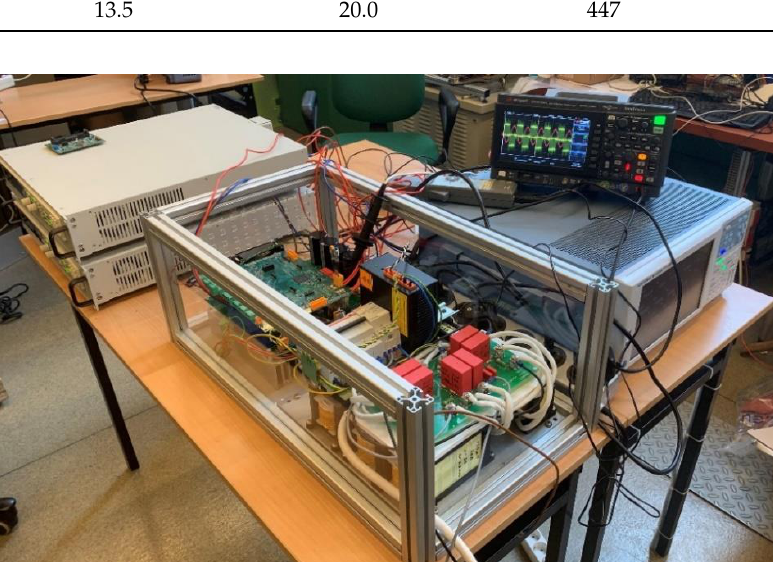
Figure 7. Experimental setup for power losses measurement in the three-phase NPC-T converter.